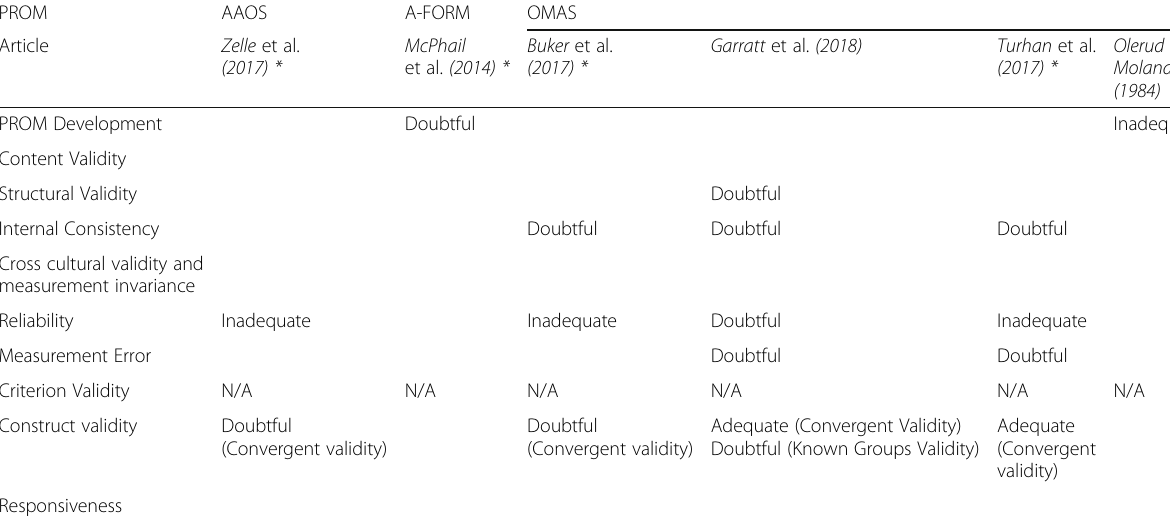
Table 4 Scores for methodological quality using COSMIN risk of bias